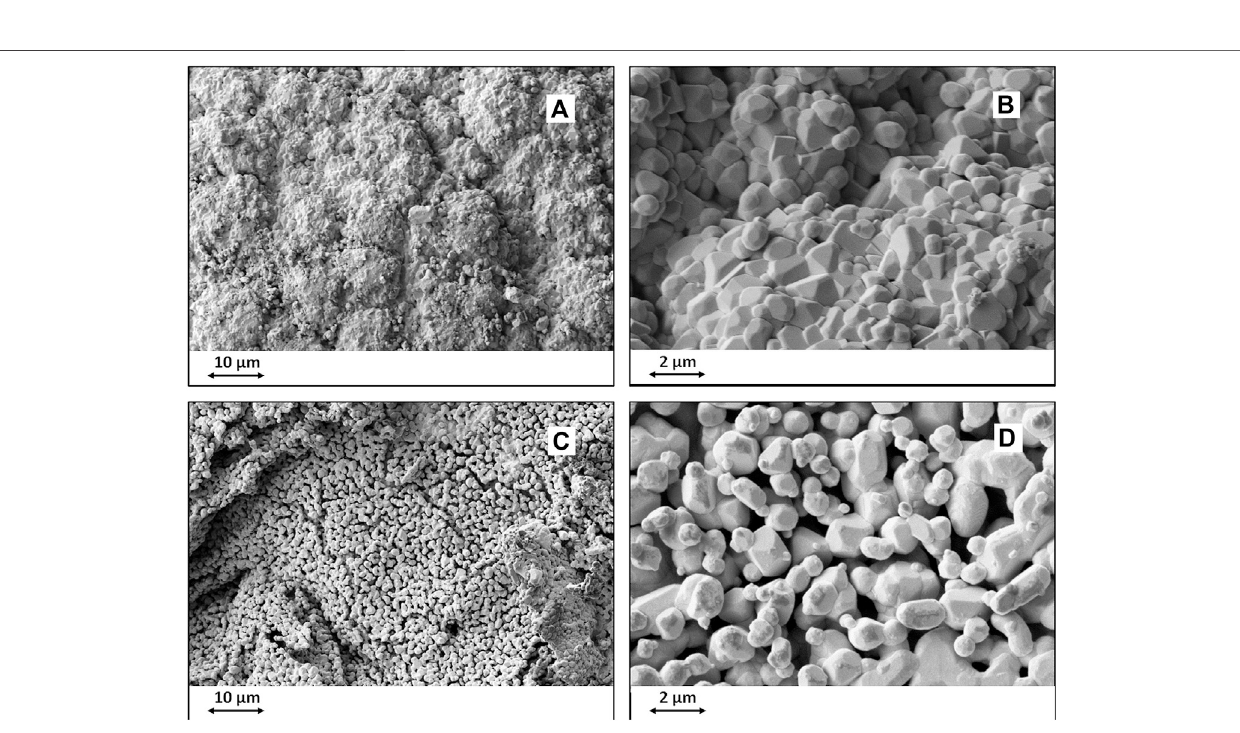
FIGURE 3 | SEM images of biomorphic CaO obtained by oxidation of CaC 2 precursor. (A,B) : CaO obtained by transformation of CaC 2 synthesized at high temperature; (C,D) ; CaO obtained by transformation of CaC 2 synthesized at low temperature. (A,C) : overall biomorphic microstructure; (B,D) : detail showing the grain size and